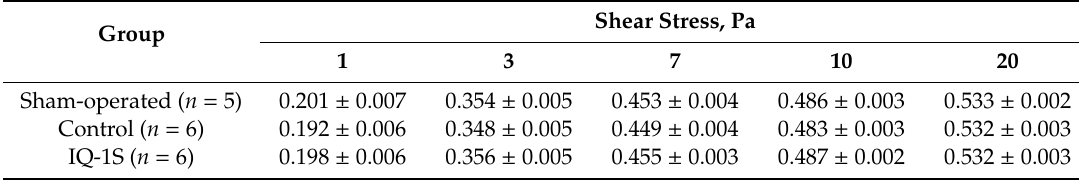
Table 5. The e ff ects of IQ-1S (50 mg / kg, i.g.) on the erythrocyte elongation index in rats at day 5 after GCI.